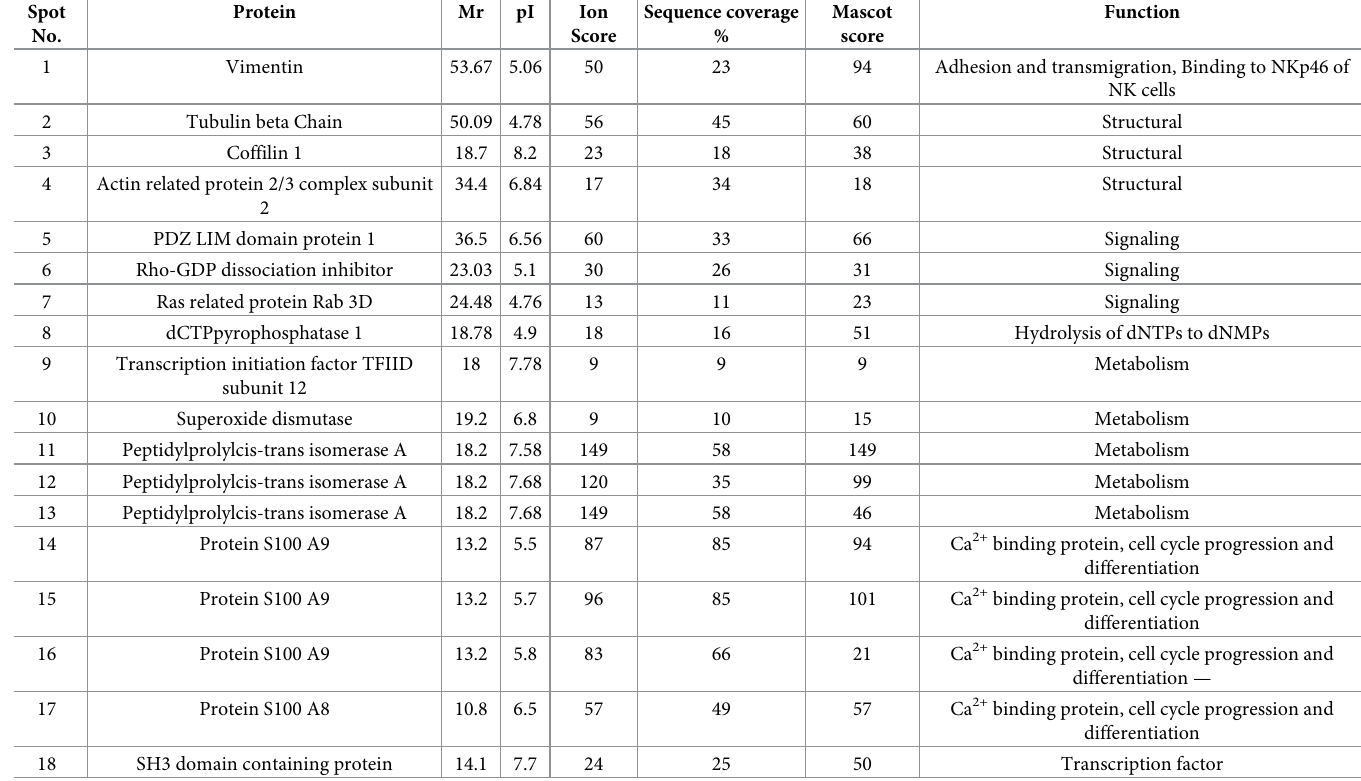
Table 4. Detailed attributes and functions of the differentially expressed proteins identified by MALDI-TOF mass spectrometry. Spot